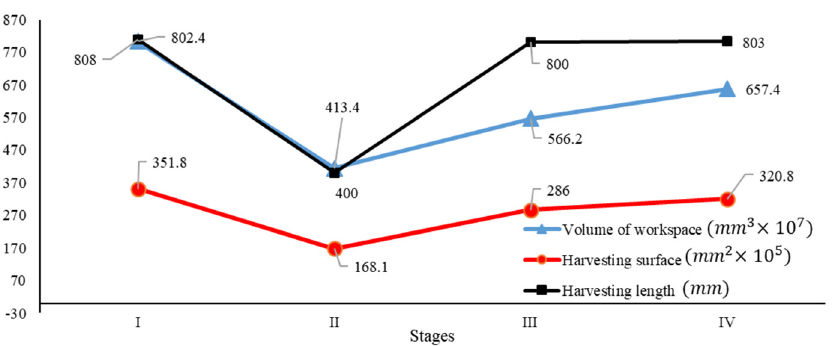
Figure 6. The workspace parameters in the different stages.